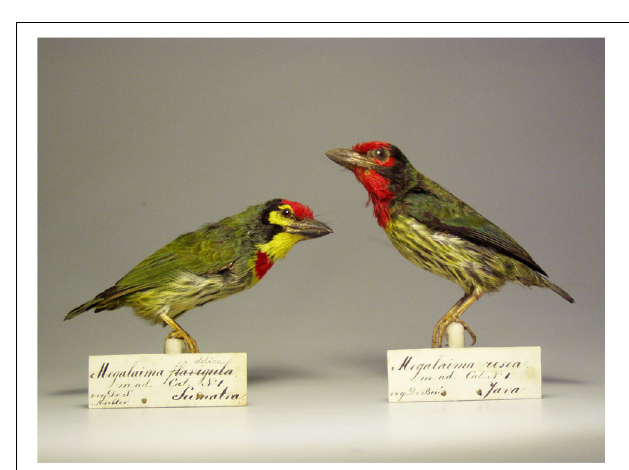
the sample numbers in Table 1 . The Singapore specimen from Genbank is not marked but located at the southern tip of the Malay Peninsula. The star indicates the approximate location of the Tenasserim Mountains, on the border of Myanmar and Thailand.